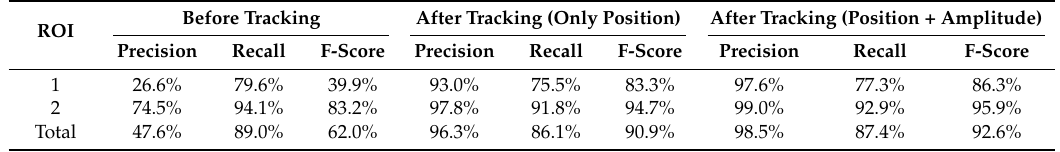
where ‘o’ and ‘+’ represent the start and of end of a track, respectively.